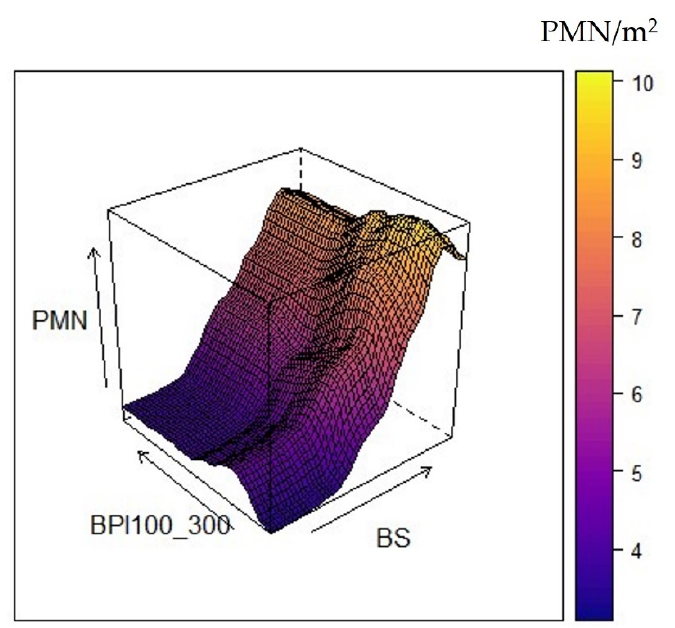
Figure A9. Three-way interaction PDP show the PMN response (colored) related to the BS, N, and E. The convex hull of the three variables is presented. The number of PMN increases with higher backscatter intensity and to the NW direction. In order to display the 3rd continuous variable (N), the PDP package converts it into shingles (a data structure that consists of a numeric vector along with four intervals that define the classes of the shingle. The intervals overlap is 10%).